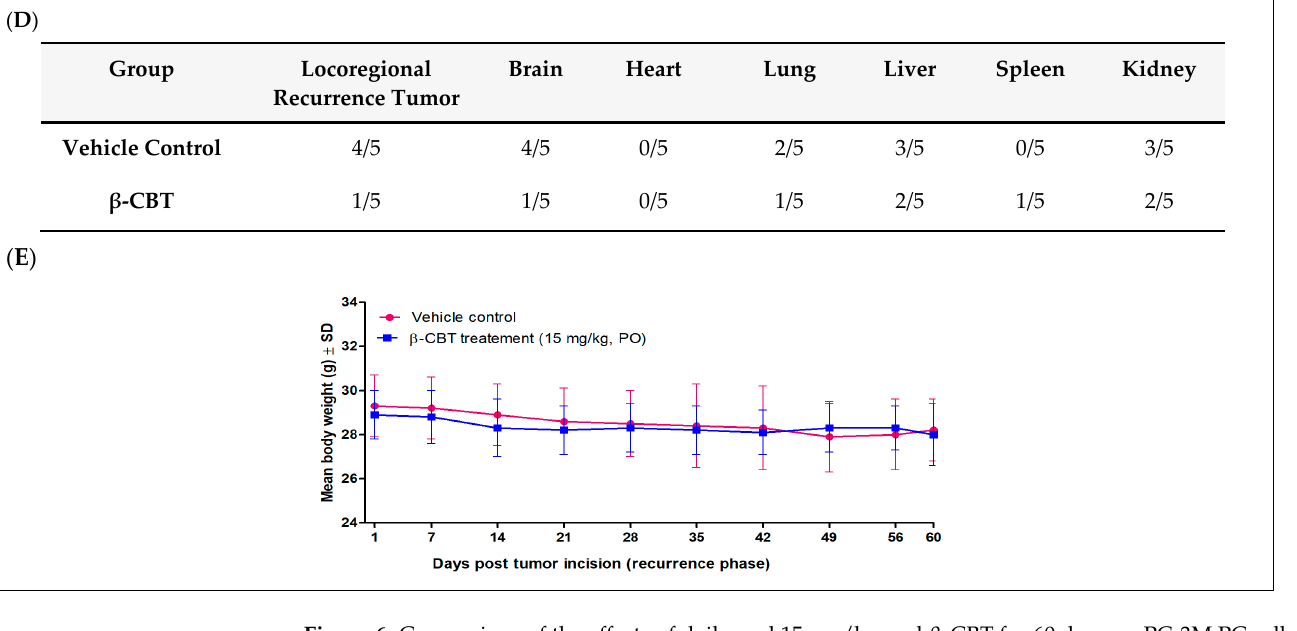
Figure 6. Comparison of the effects of daily oral 15 mg/kg oral β -CBT for 60 days on PC-3M PC cell locoregional and distant recurrence. ( A ) Bioluminescence intensity monitoring of PC-3M-Luc cells in intact animal shows the oral effect of vehicle control and ( B ) β -CBT 15 mg/kg daily oral treatments at the end of experiment course (60 days). ( C ) Bioluminescence comparison of animal organs for β -CBT-treated versus vehicle control-treated groups collected at the study end. ( D ) Number of metastatic organs in β -CBT-treated group versus vehicle control group. ( E ) Comparative monitoring of the effects of β -CBT versus vehicle control treatments on the mean mice total body weight over the recurrence-phase course (60 days). Data points represent mean body weight per group in g ± SD. The mean body weights comparison between vehicle-treated control and β -CBT-treated groups was statistically non-significant, p < 0.05.